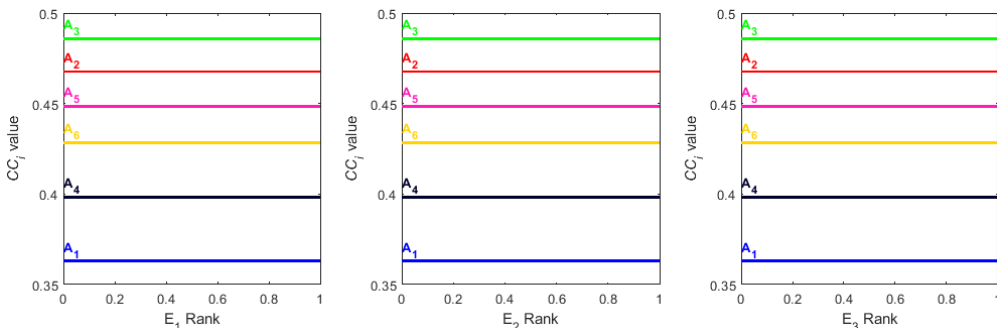
Figure 7. Closeness coefficient values depending on the rank of experts ( 𝛽 = 0 ).